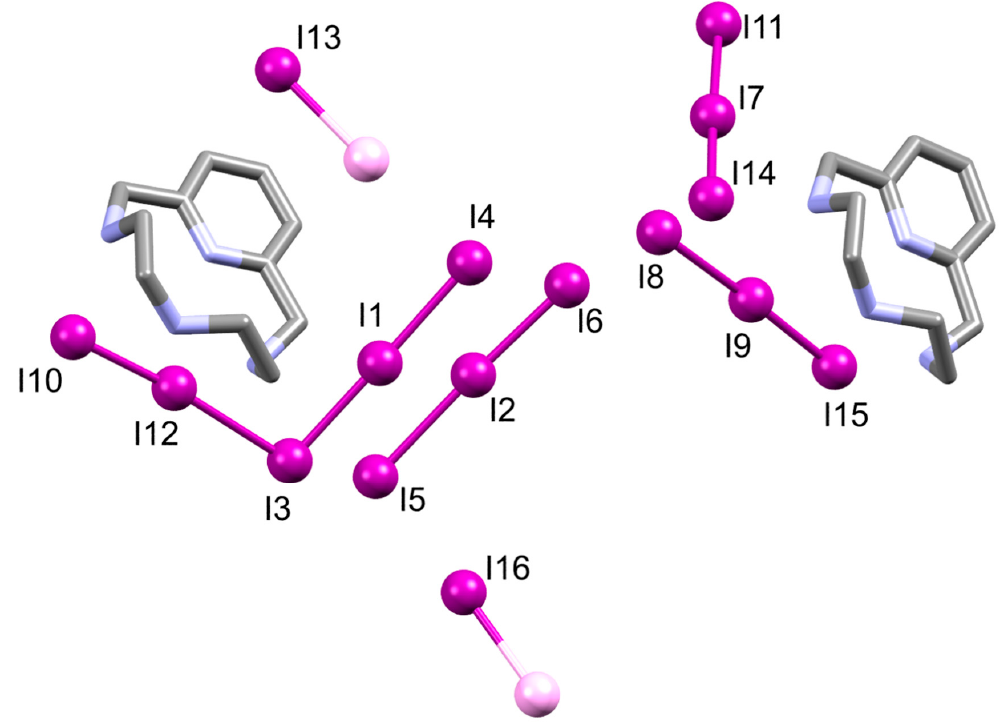
Figure 4. Content of the asymmetric unit of the [(H 2 L1) 2 I 2 (I 5 )(I 3 ) 3 ] crystals. Color code: white, H; grey, C; cyan, N; violet, I; halved non-equivalent I 2 molecules have been completed in the picture in light violet to avoid misperception.